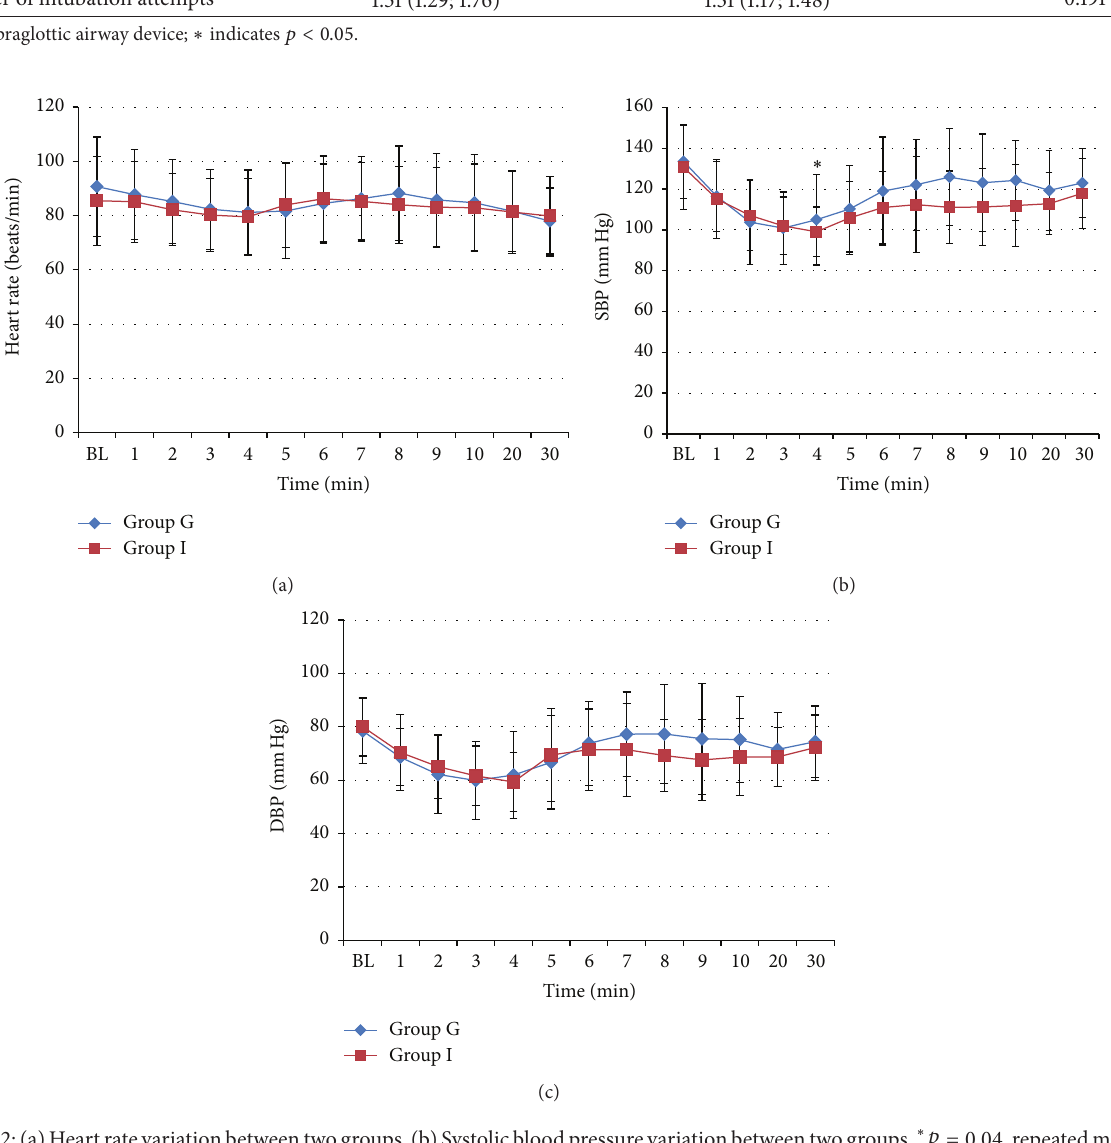
were significantly longer with I-Gel even when corrected for skewed distribution using